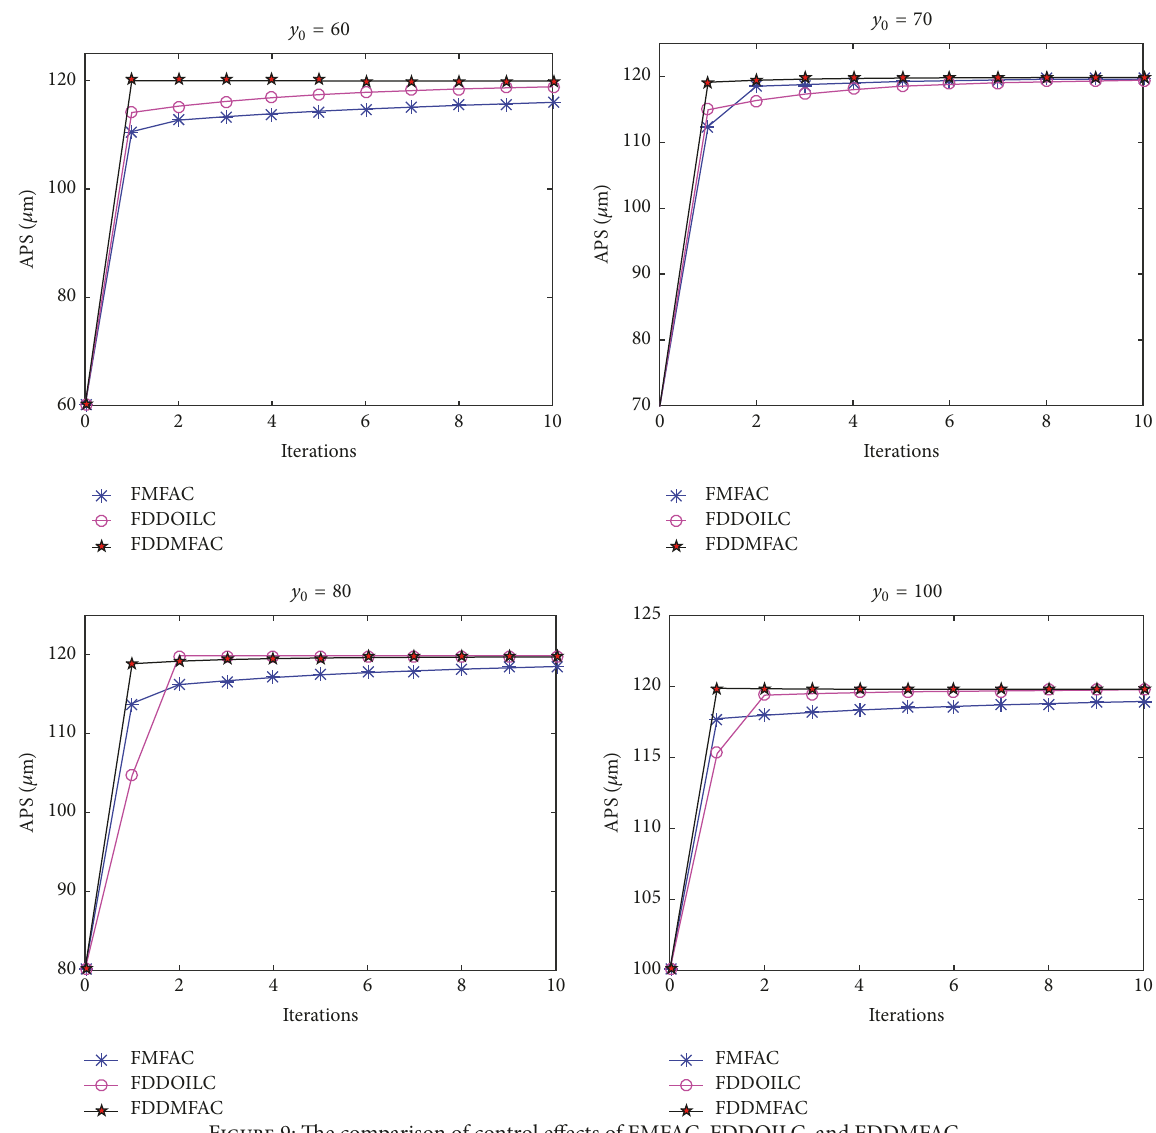
Figure 9: The comparison of control effects of FMFAC, FDDOILC, and